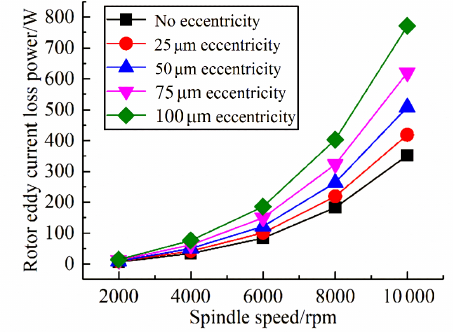
Figure 7. Stator hysteresis loss power with different rotating speed and eccentricity.